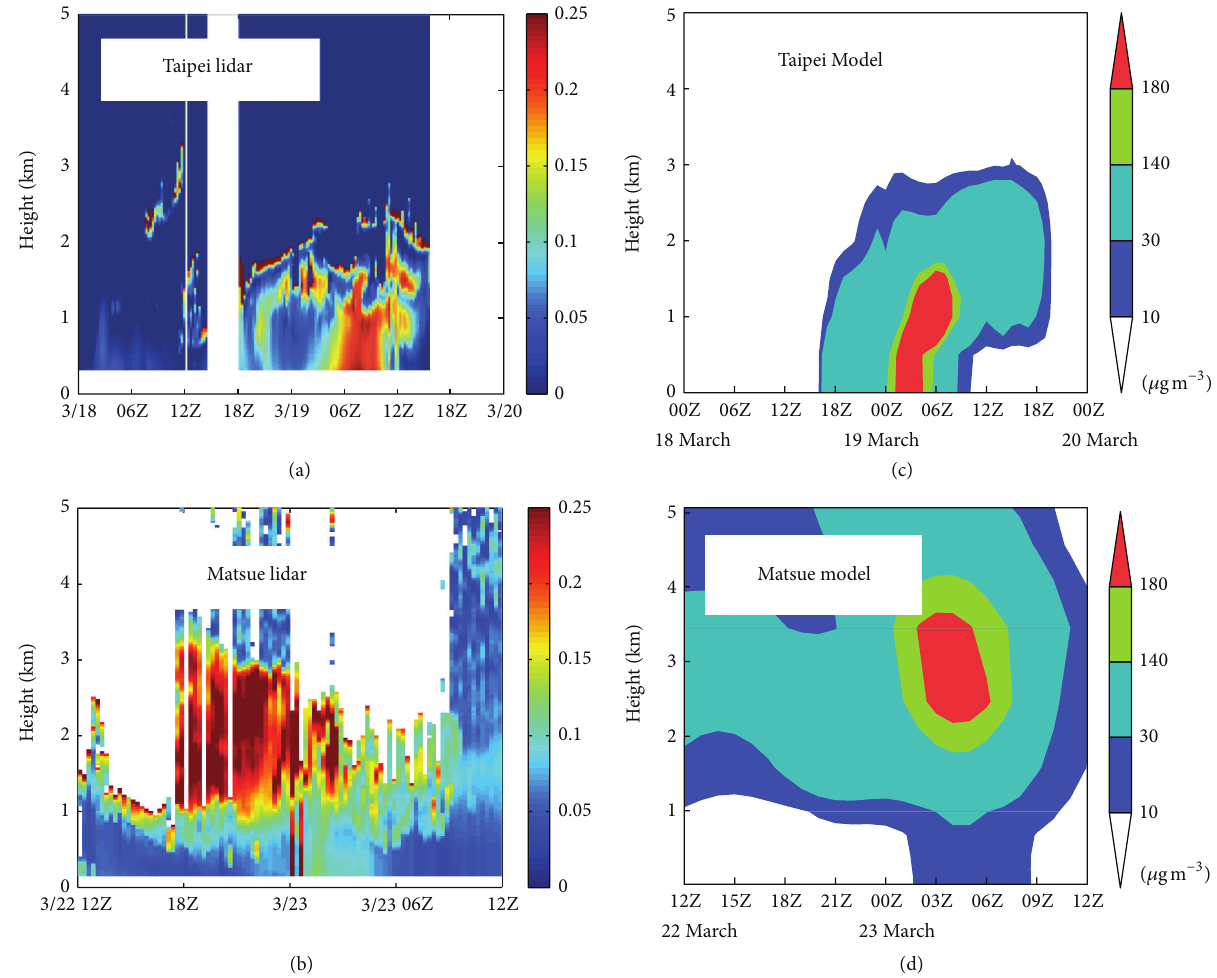
Figure 4: Vertical distributions of dust observed by lidar total depolarization ratio ( > 0.06 indicates dust) for the (a) southeastward event at Taipei, Taiwan, on 18–20 March and (b) eastward event at Matsue, Japan, on 22-23 March and compared with model simulation at (c) and (d),